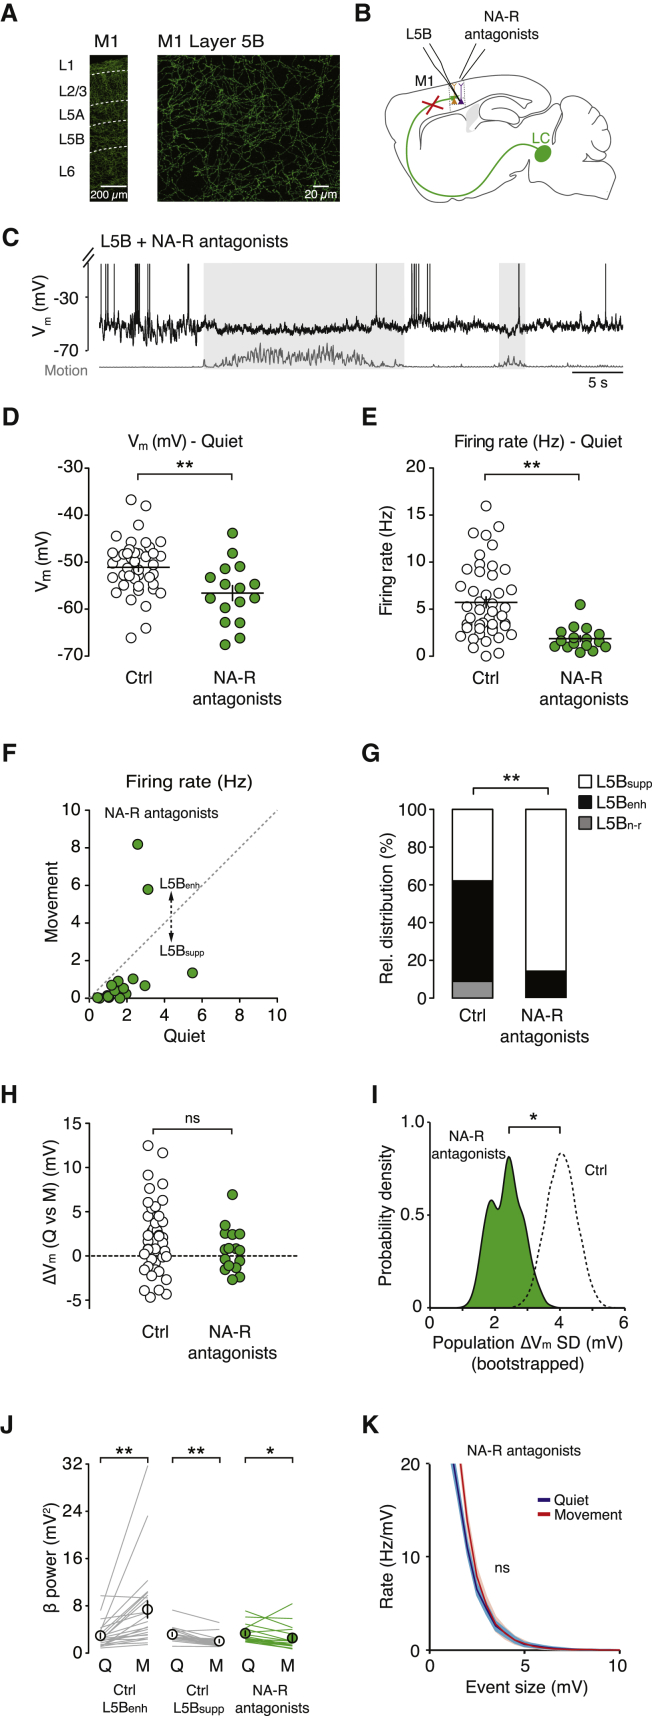
Blocking Input from the LC Reduces Behavioral State-Dependent Increase in Excitatory Drive in L5Benh Neurons(A) Noradrenergic axons in the forelimb region of M1 were labeled using an anti-noradrenaline transporter antibody and secondary antibody conjugated to AlexaFluor 488.(B) Schematic representation of an L5B pyramidal neuron recording after blocking noradrenergic input from the LC.(C) Representative voltage trace from a L5B pyramidal neuron in the absence of noradrenergic input.(D and E) Average Vm (D) and firing rate (E) of L5B pyramidal neurons during quiet wakefulness in the absence (open symbols, n = 45) and presence (green symbols, n = 16) of noradrenergic receptor (NA-R) antagonists. Filled circles represent data from individual neurons, black bars represent mean ± SEM. Control data (Ctrl) were taken from the dataset presented in Figure 1 for comparison. Mann-Whitney U test, ∗p < 0.017, ∗∗p < 0.003.(F) Average firing rate of L5B pyramidal neurons in the presence of noradrenergic receptor antagonists (n = 16) during quiet wakefulness and movement. Filled circles represent data from individual neurons.(G) Relative distributions of L5Bsupp, L5Benh, and L5Bn-r neurons in the absence (Ctrl) and presence (NA-R antagonists, n = 16) of noradrenergic receptor antagonists. Control data (Ctrl) were taken from the dataset presented in Figure 1 for comparison. Chi-square test, ∗∗p < 0.01.(H) Change in average Vm (ΔVm) during movement in the absence (Ctrl, n = 41) and presence of noradrenergic receptor antagonists (green symbols, n = 16). Control data (Ctrl) were taken from Figure 1 for comparison. Mann-Whitney U test; ns, non-significant.(I) Probability density distributions of ΔVm variability across the L5B pyramidal neuron population (Ctrl and NA-R antagonists), measured as the SD of the ΔVm distributions shown in (H) (Population ΔVm SD) using bootstrap analysis (10,000 bootstrap replicates). Black dashed line represents population ΔVm variability distribution in control (Ctrl), and green shading represents population ΔVm variability distribution following noradrenergic receptor blockade. Control data (Ctrl) were taken from Figure 1 for comparison. F test, ∗p < 0.025.(J) Average L5B pyramidal neuron Vm power in the β frequency band (12–30 Hz) during quiet wakefulness and movement in the presence (Ctrl: L5Bsupp, n = 17 and L5Benh, n = 24) and absence of noradrenergic input (NA-R antagonists, n = 16). Solid lines represent data from individual neurons, symbols represent mean ± SEM. Control data (Ctrl) were taken from Figure 3 for comparison. ∗p < 0.05.(K) Average rate density of compound synaptic events in L5B pyramidal neurons during quiet wakefulness (blue) and movement (red) in the absence of noradrenergic input (n = 16). Compare with Figures 3I and 3J.See also Figures S5 and S6.